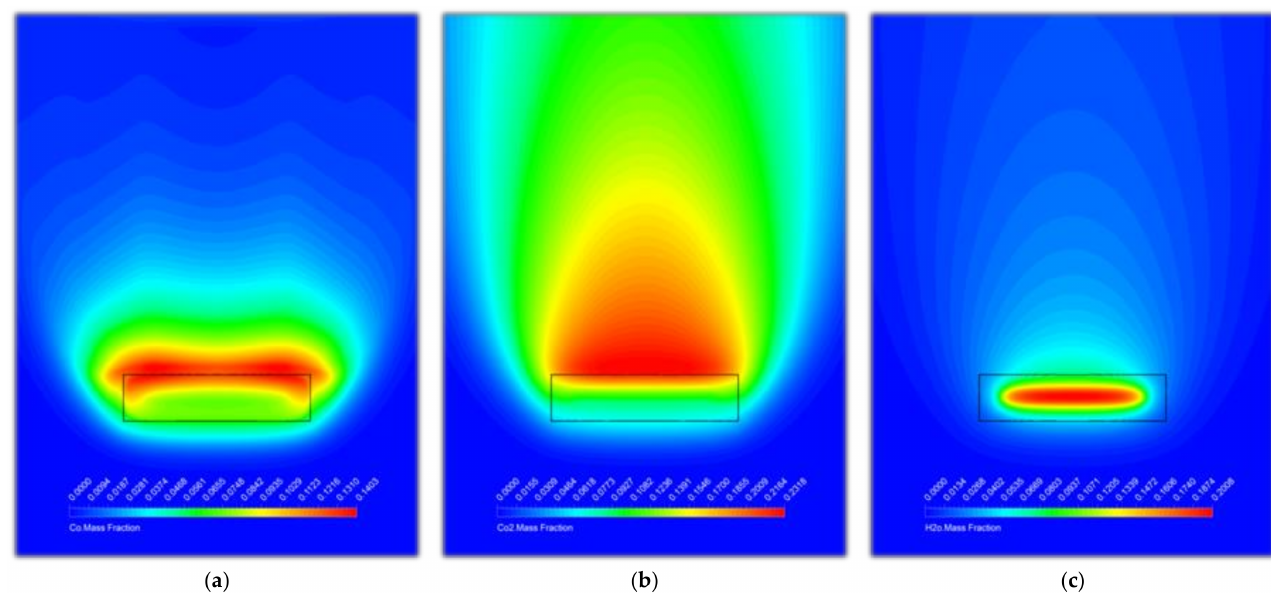
Figure 18. Mass fraction ( a ) CO, ( b ) CO 2 and ( c ) H 2 O at t = 25 s; maximum values: ( a ) 0.1403, ( b ) 0.2318 and ( c ) 0.2008. Figure 19 shows the same species at t = 50 s, when, unlike the first particle, there is still an important fraction of unconverted biomass. Maximum values of species concentrations are: CO = 13.6%, CO 2 = 24.2%, s i H 2 O = 2.1%, similar values to the previous time moment, , with the exception of water. Flame temperature at this stage is ≈ 1800 K.